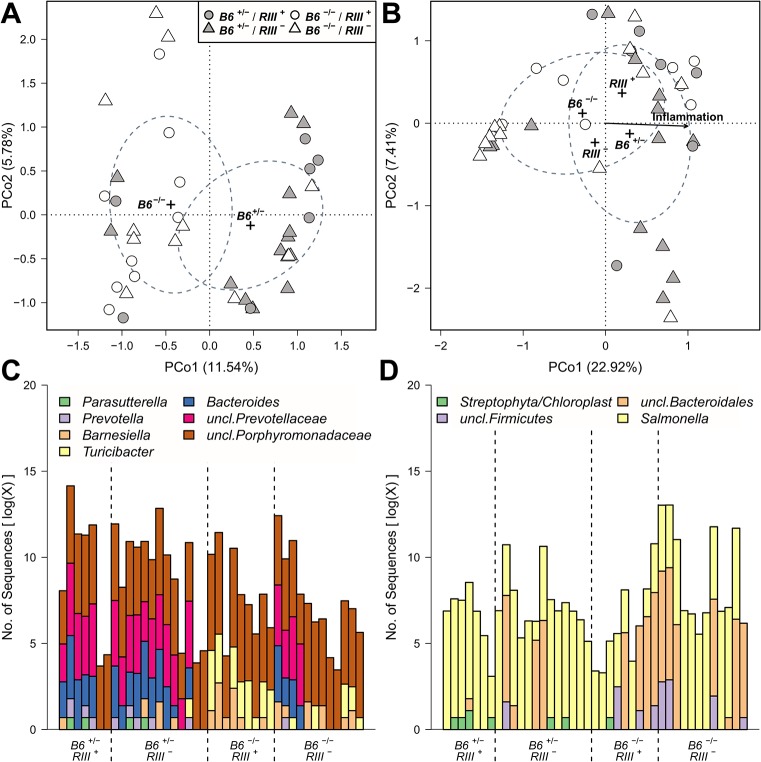
Treatment wise Principle Coordinate Analysis (unweighted UniFrac) of untreated- and S. Typhimurium inoculated mice and distribution of indicator bacteria among mice.The significant sample clusters and correlations are shown, displaying a strong influence of epithelial B4galnt2 expression on the microbial community composition (no treatment (A): R
2 = 0.1480, P = 0.0019; Salmonella treatment (B): B6: R
2 = 0.0607, P = 0.08669, RIII: R
2 = 0.0781, P = 0.040, inflammation: R
2 = 0.5531, P<0.0001). Abundance distribution of indicator genera before (C) and after S. Typhimurium infection (D) for B4galnt2 gut expression among mice.